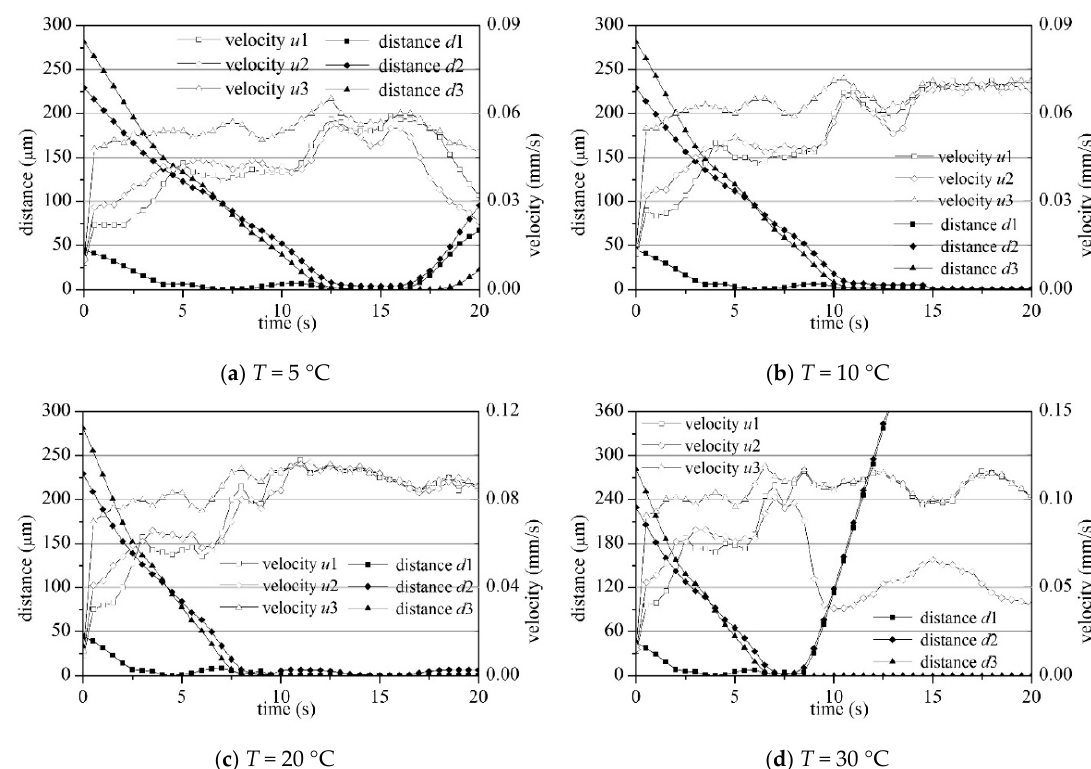
Figure 5. Time series of particle velocities and particles’ net distance, i.e., h ij in Equation (8) and r ij − R i − R j in Figure 3. Solid symbols are net distances, and hollow symbols mean velocities. d 1 represents the distance between particles #681 and #689; d 2 represents that between particles #689 and #721; d 3 represents that between particles #681 and #721; u 1, u 2, and u 3 represent the settling velocities of particles #681, #689, and #721, respectively. The left axes are for the distance, and the right ones are for the velocities. ( a ) T = 5 °C; ( b ) T = 10 °C; ( c ) T = 20 °C; and ( d ) T = 30 °C.